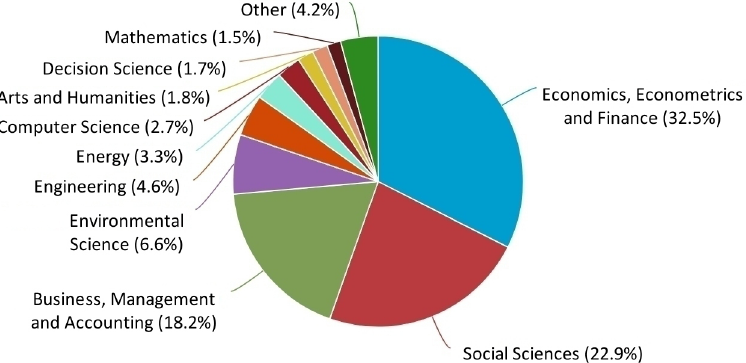
Figure 2. Documents by subject area (source: Scopus